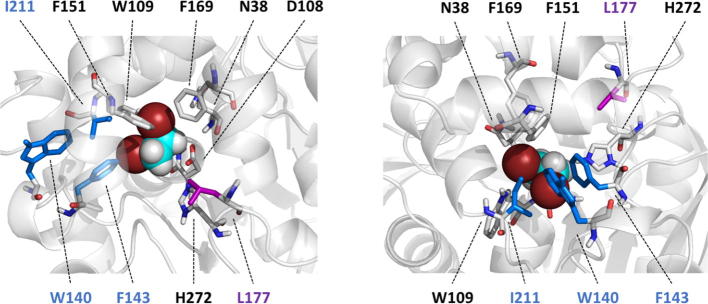
The NAC conformation of DBE in LinBwt viewed from the main tunnel (left) and from the p3 tunnel (right). As a small molecule, DBE does not interact with many residues besides the catalytic pentad D108, H272, N38, W109 and E138 (not within 4 Å to DBE and thus not shown). DBE is shown as spheres and residues within 4 Å from DBE and the mutated residues are shown as sticks. The mutated residues in the variants follow the color scheme presented in Fig. 1. DBE is shown with the following color coding: brown = bromine, cyan = carbon and white = hydrogen. (For interpretation of the references to color in this figure legend, the reader is referred to the web version of this article.)